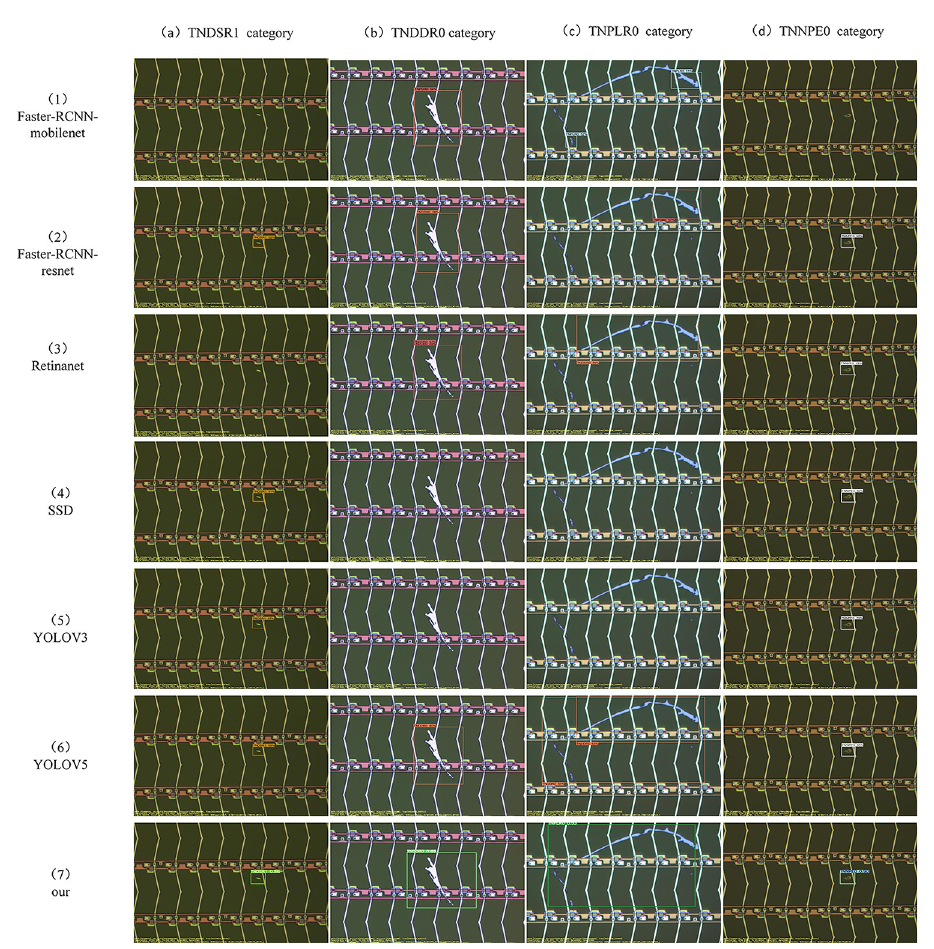
Fig 9. Test results of each trained network on the four categories of TNDSR1, TNDDR0, TNPLR0, TNNPE0.